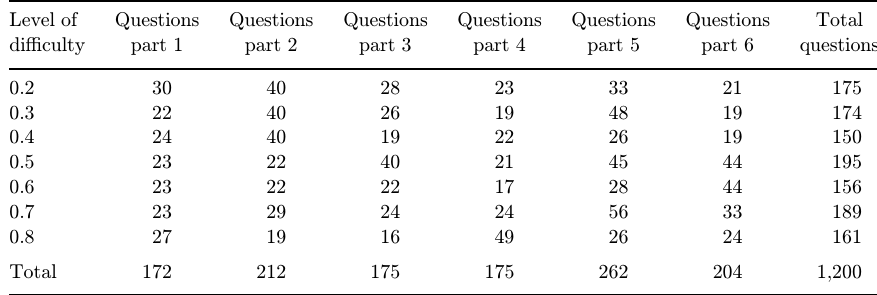
Table 1. Experimental data of large question bank.